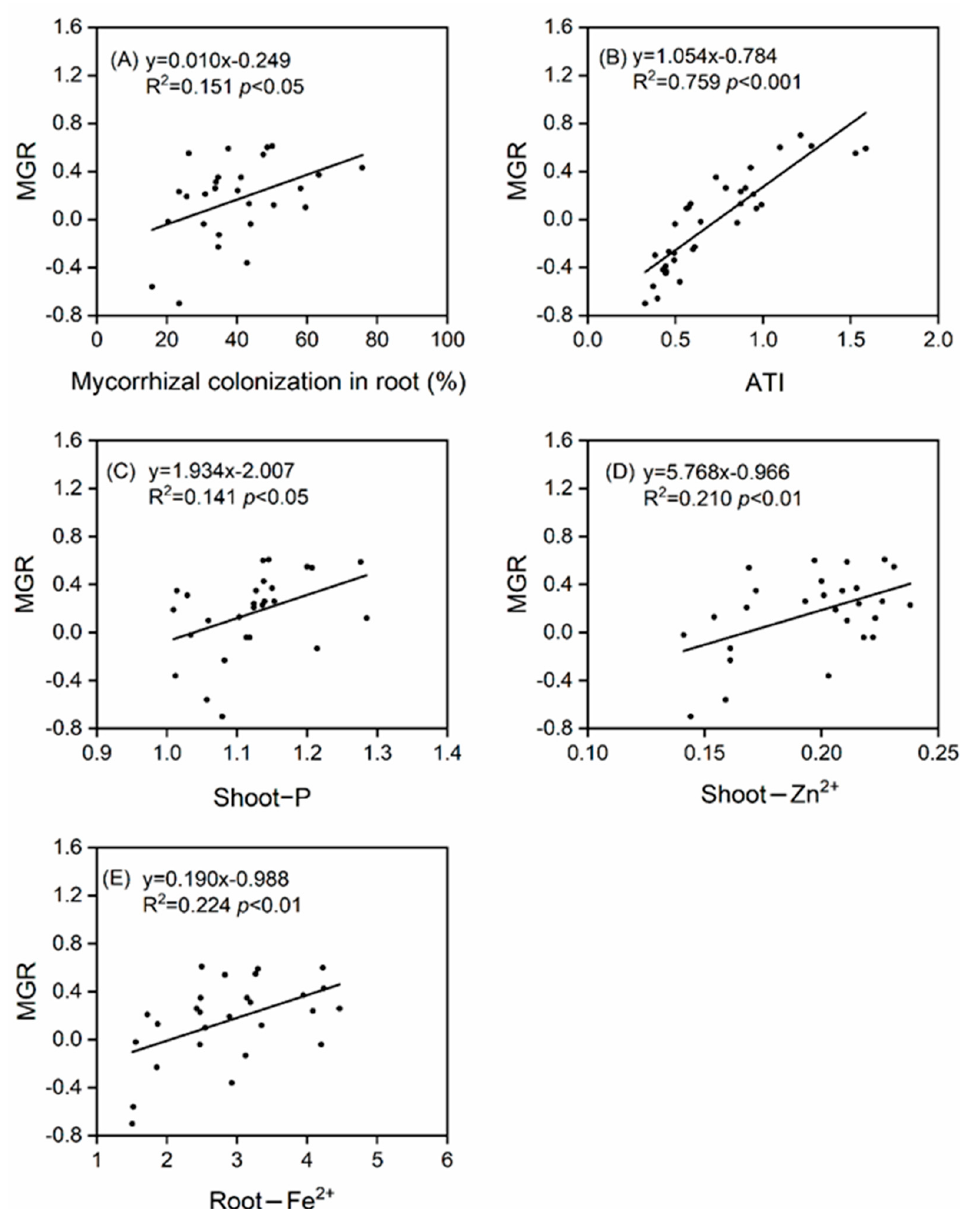
Figure 7. Relationships between mycorrhizal growth response (MGR) and mycorrhizal colonization ( A ), acid − tolerance index (ATI) ( B ), shoot − P ( C ), shoot − Zn 2+ ( D ), and root − Fe 2+ ( E ) of Torreya grandis under the interactions of arbuscular mycorrhizal fungi and acid rain.